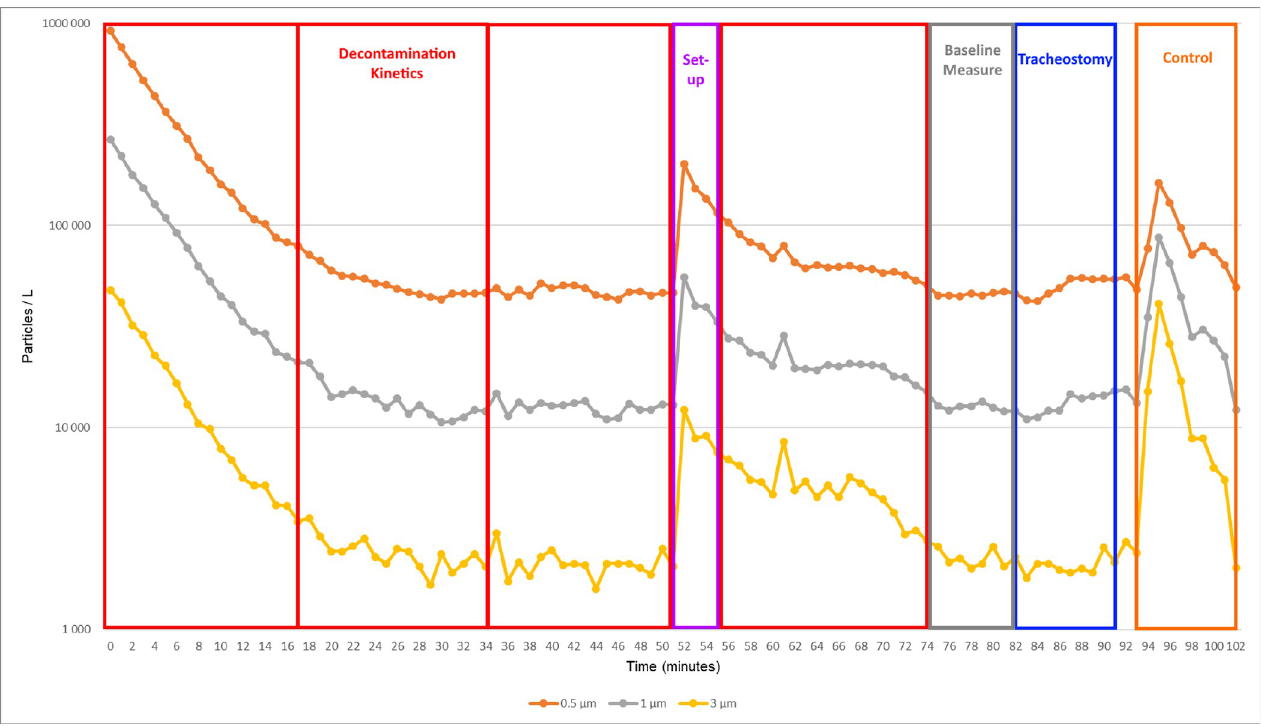
Fig 3. Particle count variations (logarithmic scale) during decontamination kinetics, set-up, baseline measurement, tracheostomy procedure and control maneuver. The sequence depicted here is as short as possible. At least three decontamination periods of 16 minutes before the set-up of the experiment were required. The set-up is generating airborne particles due to the entrance of the operators in the room. Thus, another decontamination period was performed before baseline measurement. 30 minutes after the set-up (equivalent to 2 decontamination kinetics), the operators were allowed to begin the procedure. An intentional aerosol-generating maneuver was then performed to control the effectiveness of airborne particle